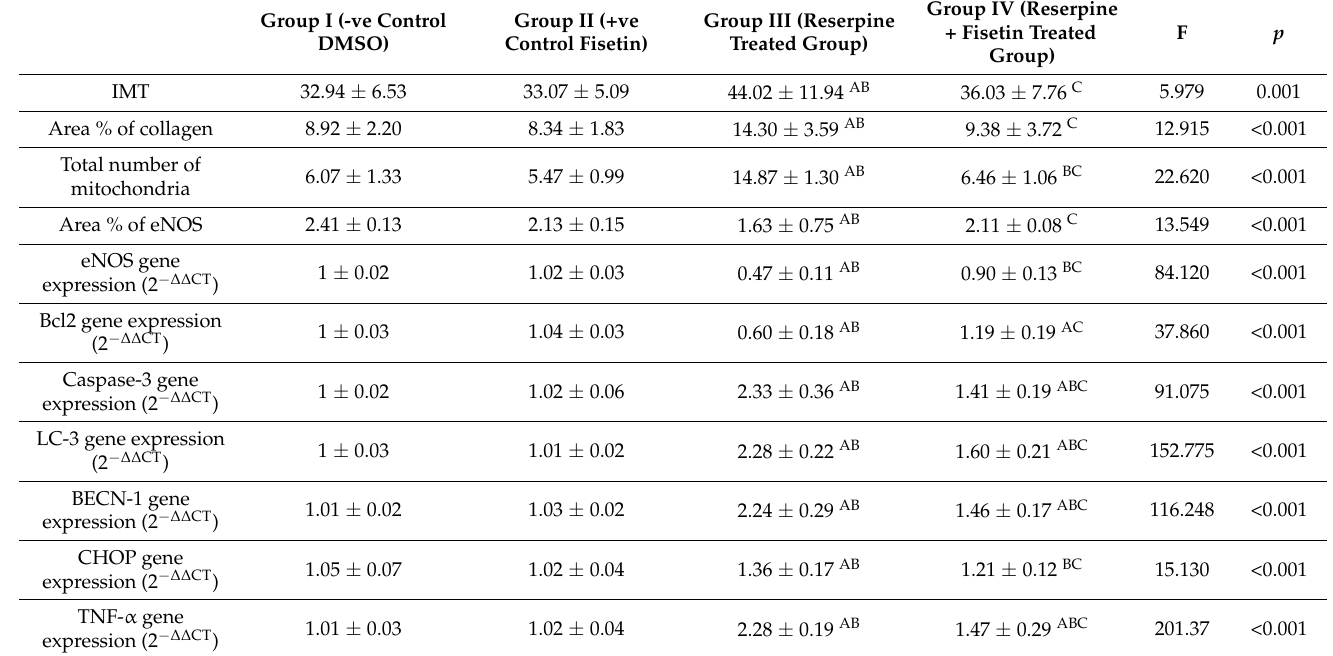
Table 2. Histological and molecular parameters of the carotid artery of all studied animal groups. Group I (-ve Control Group II (+ve DMSO) Control